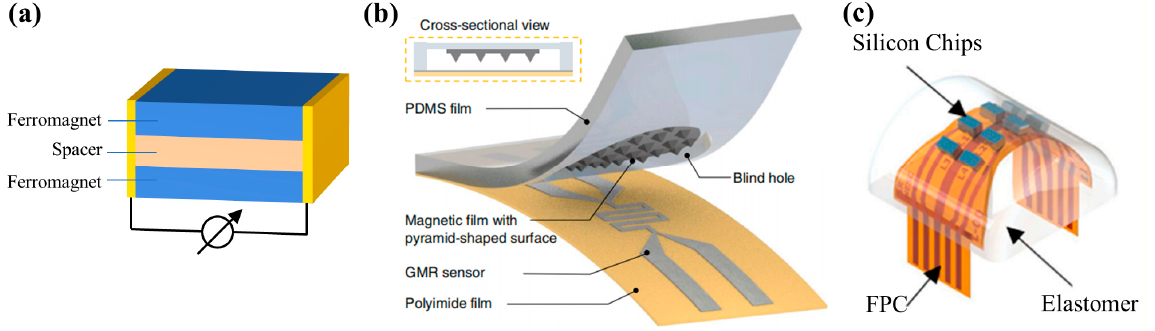
Figure 3. ( a ) Illustration of the spin valve structure of GMR sensors; ( b ) Thin-film magnetic tactile skin with GMR multilayer films (designed by Jin Ge). Reprinted with permission from Ref. [68]. Copyright 2019, Springer Nature; ( c ) Flexible-rigid hybrid tactile sensor (designed by Miguel Neto). Reprinted with permission from Ref. [69]. Copyright 2021,